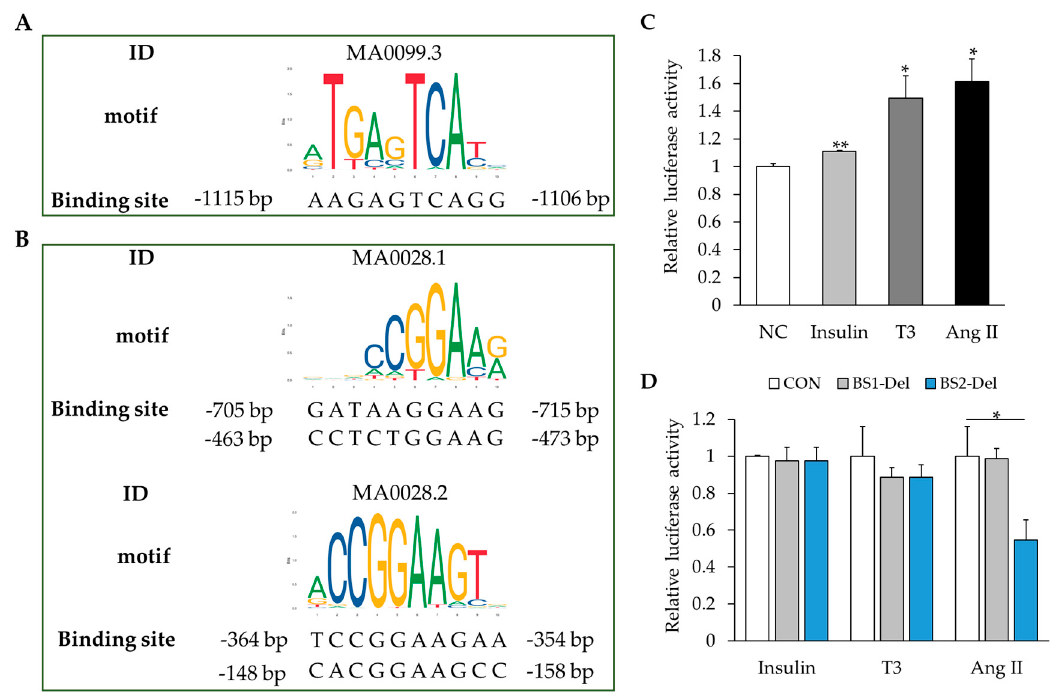
Figure 5. Analysis of promoter activity of RBM20 gene. ( A ) The binding site of c-jun in the RBM20 promoter region; ( B ) Binding sites of ELK1 in the RBM20 promoter region; ( C ) Relative luciferase activities of CON RBM20 promoter with different treatments. Luciferase activity of untreated control was set as “1.0”; ( D ) Relative luciferase activities of MUT RBM20 promoter with different treatments. With each treatment, the luciferase activity of the CON promoter was set as “1.0”. CON, pGL3-basic vector containing RBM20 promoter fragment. BS1-Del, pGL3-basic vector containing RBM20 promoter fragment from which binding site of c-jun was deleted. BS2-Del, pGL3-basic vector containing RBM20 promoter fragment from which binding sites of ELK1 were deleted. Mean ± SE ( n = 3), * p < 0.01, ** p < 0.01.